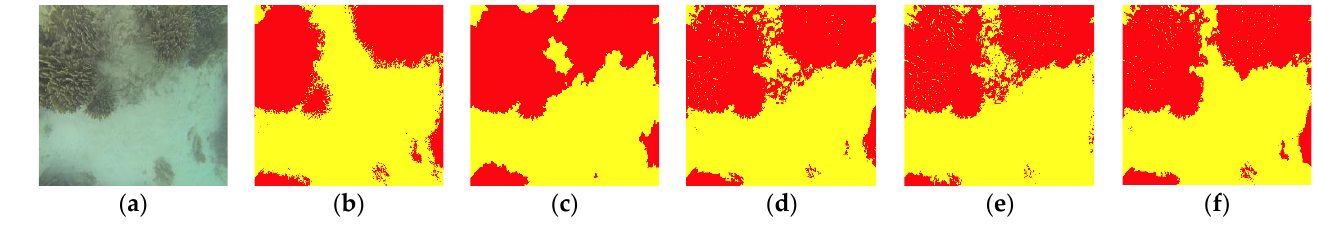
Figure 17. Validation tests of the proposed segmentation algorithms using highly illuminated and low contrast blue corals image (1) from Figure 15 as example of two categories: ( a ) original image; ( b ) ground truth image; ( c ) FF result; ( d ) FR result; ( e ) OS result; ( f ) KM result. Red: blue corals and yellow: sediments.